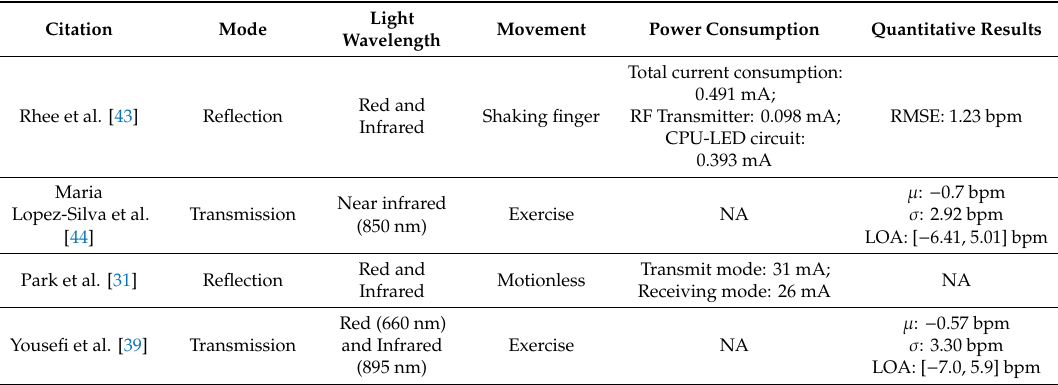
Table 2. Summary of finger-type photoplethysmography (PPG) sensors for HR monitoring.